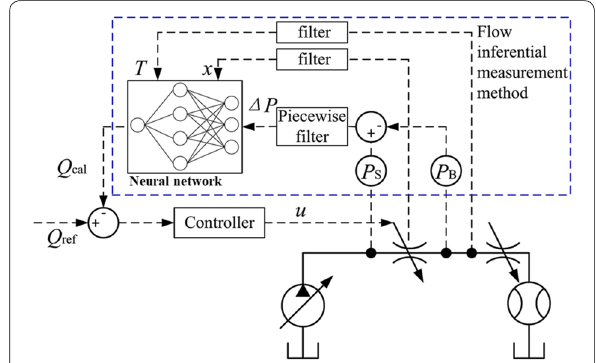
Figure 4 Flow measurement method based on the AdaBoost neural